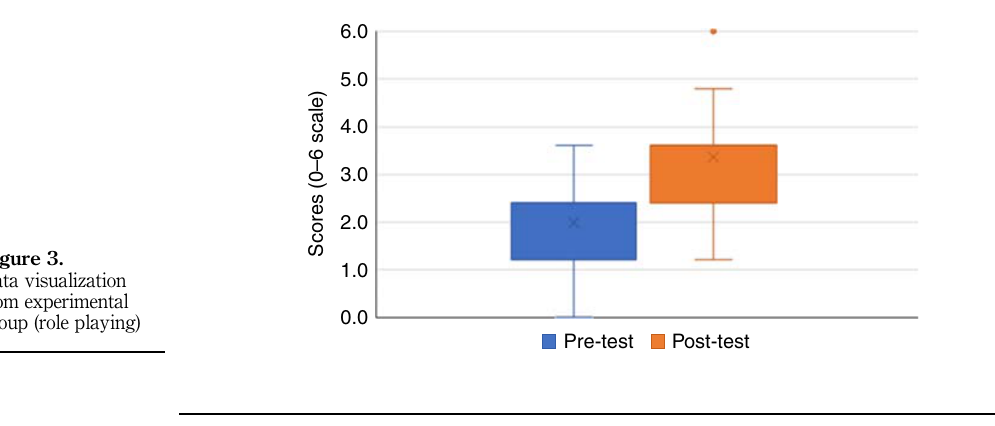
Figure 2. Data visualization from control group (Traditional